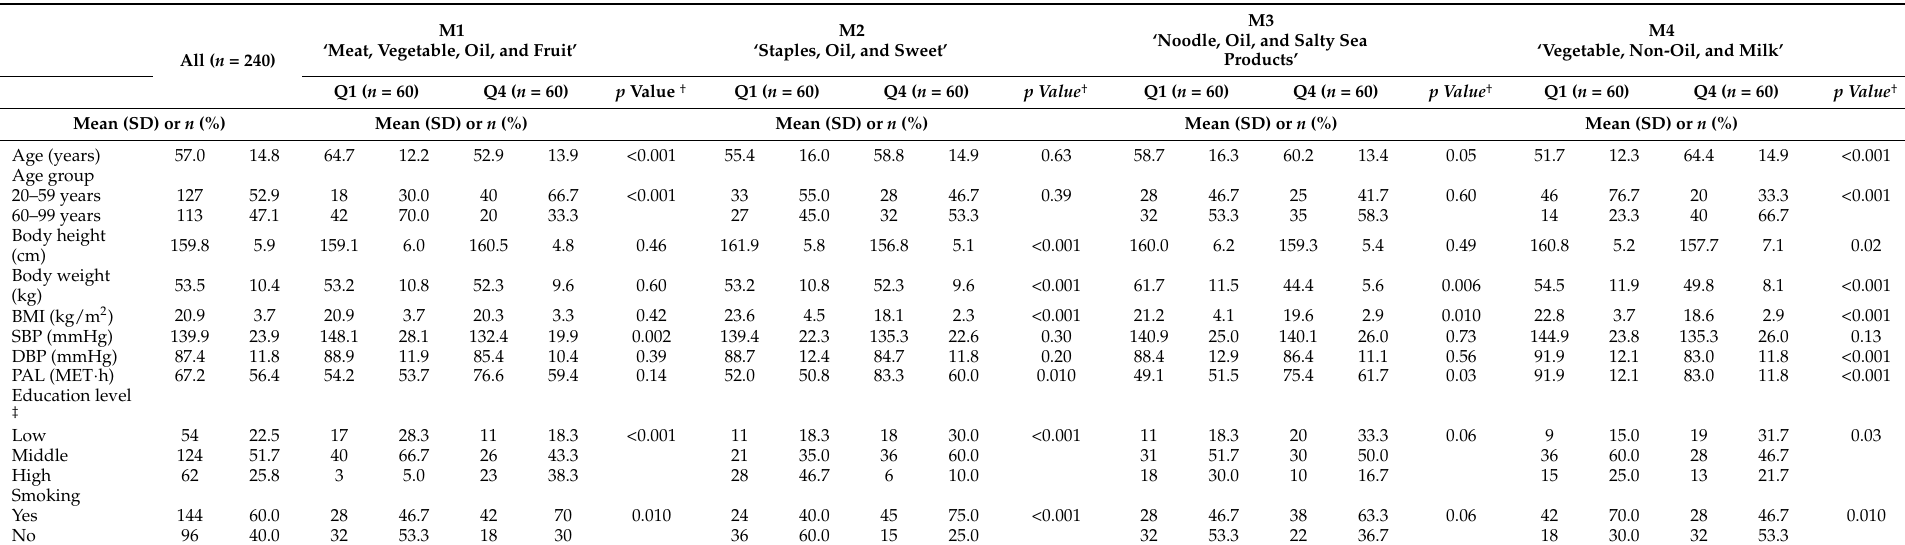
Table 1. Participants’ characteristics for the lowest (Q1) and highest (Q4) for men n = 240